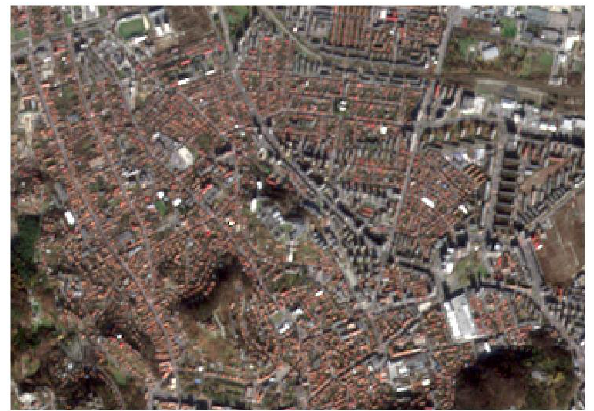
Figure 2 . Study zone